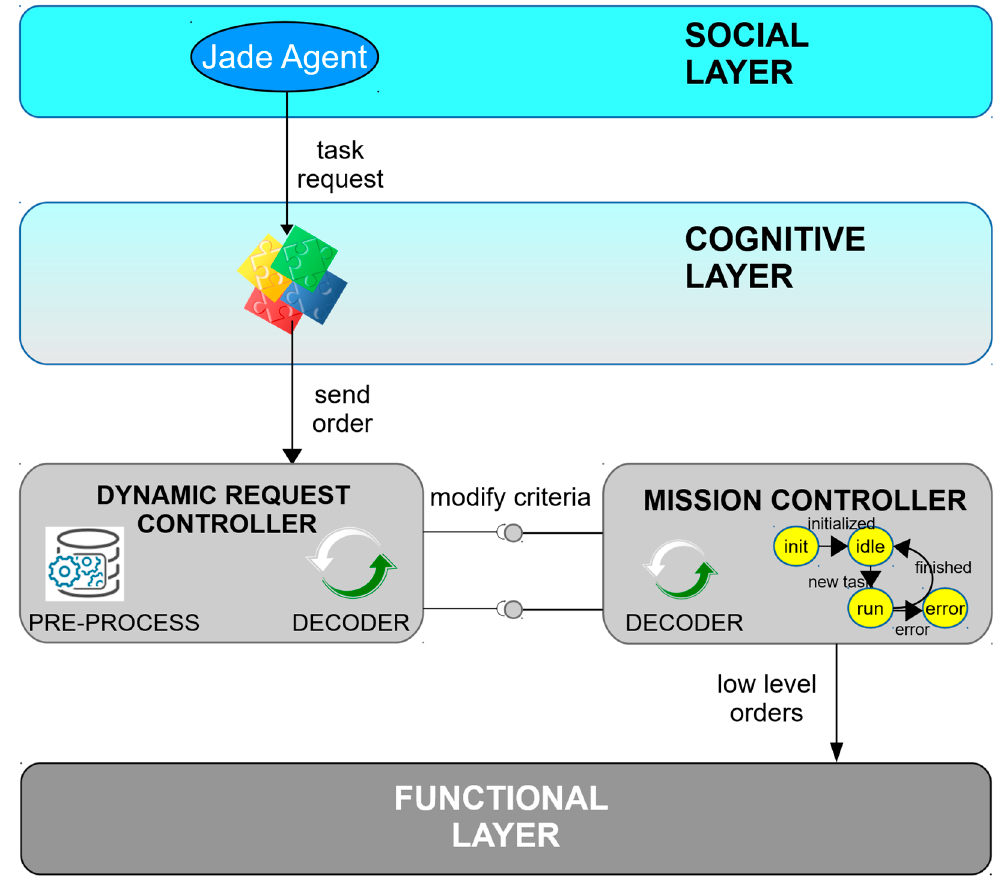
Figure 11. ATV reconfiguration triggered by the Dynamic Request Controller to increase the ATV velocity.